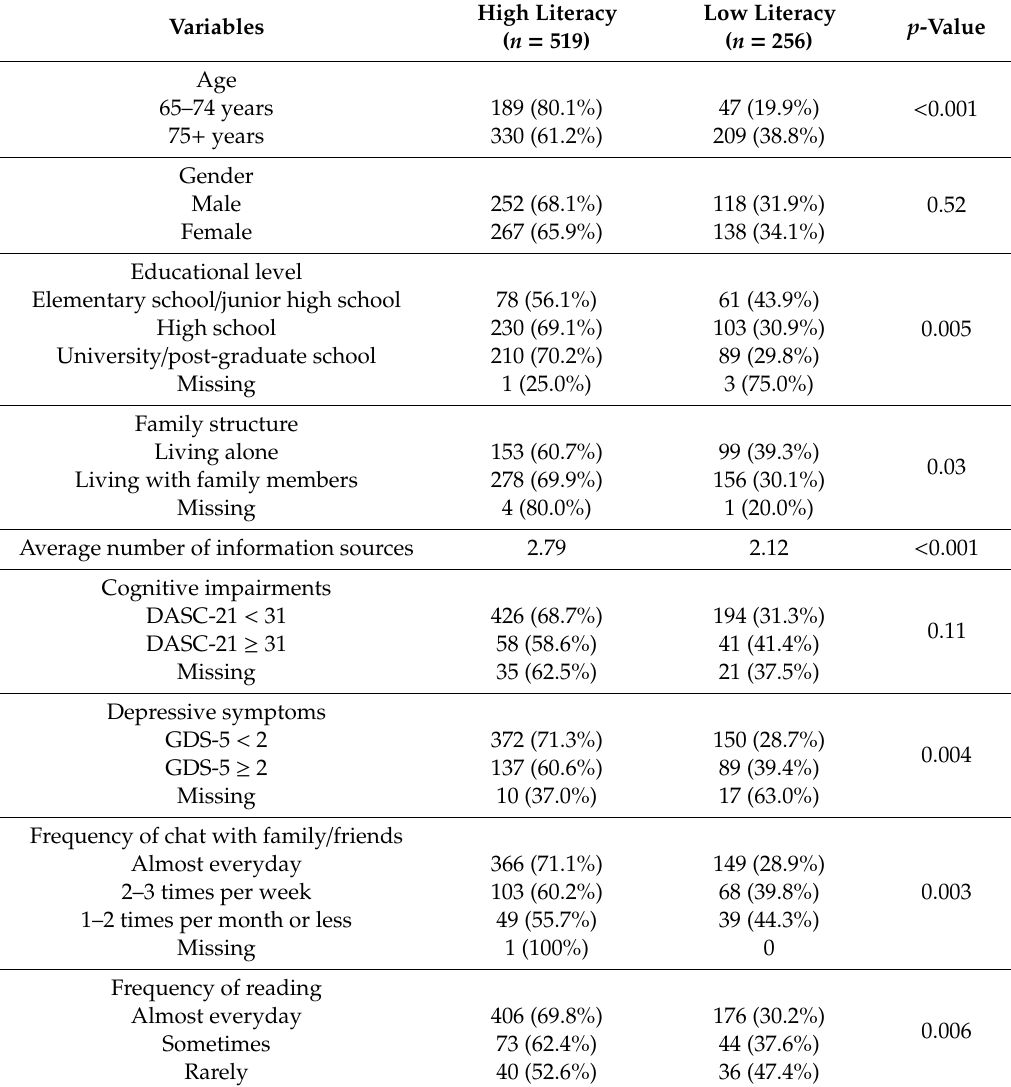
Table 2. A chi-square test to identify factors associated with dementia literacy ( n = 775).